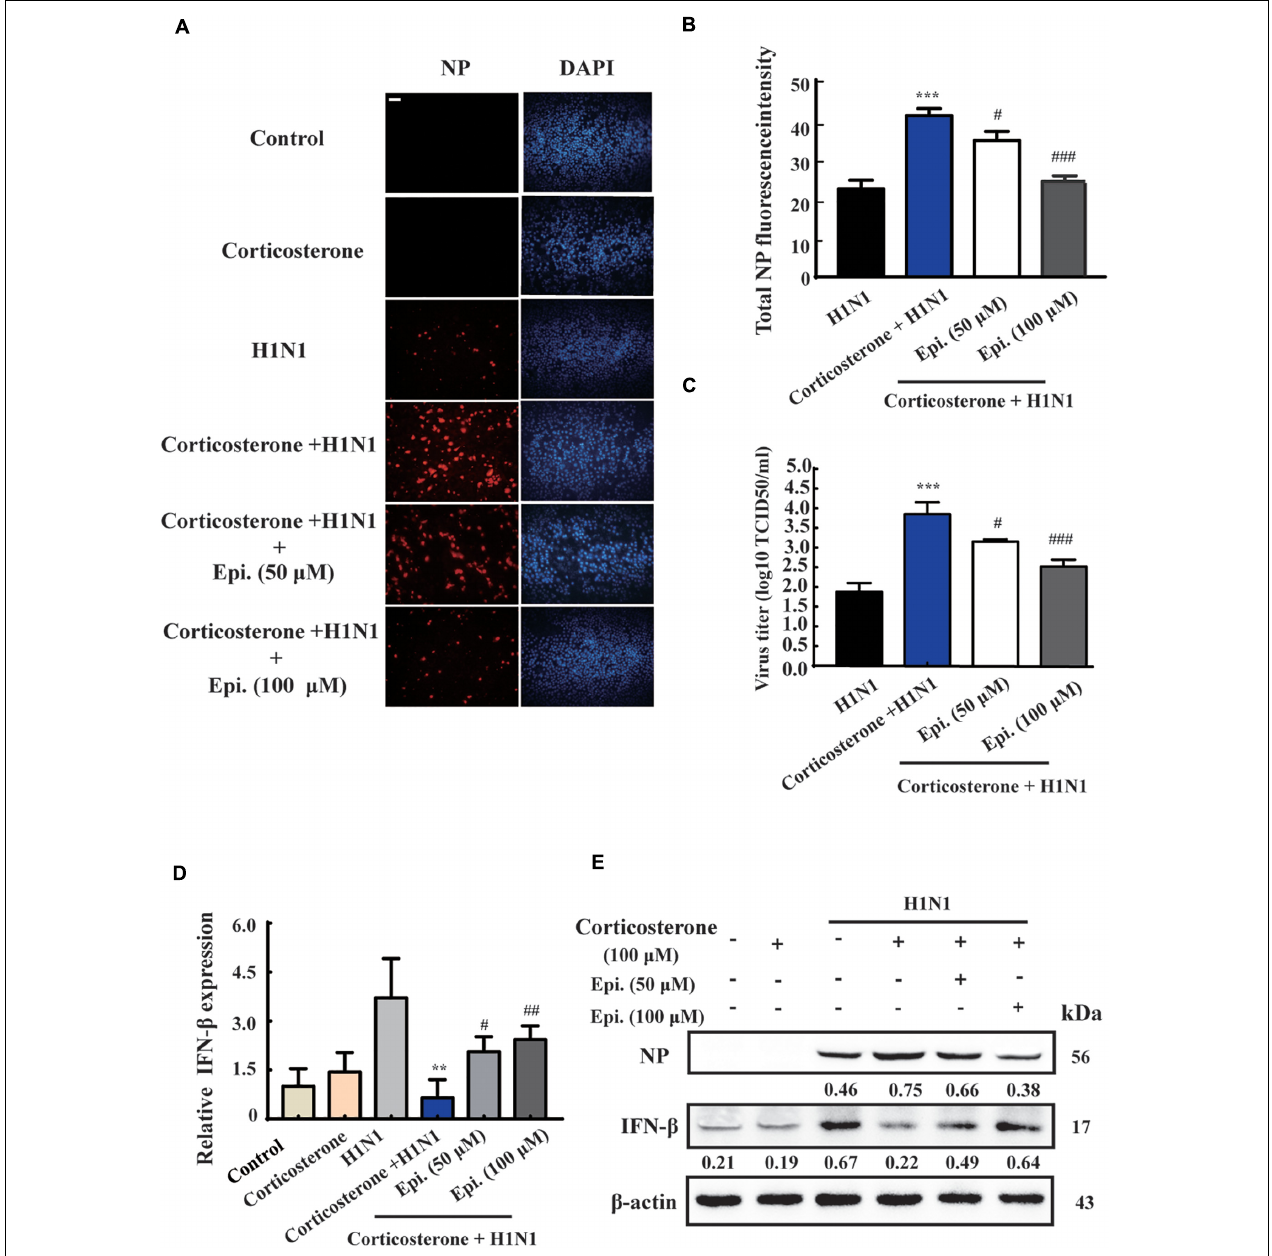
FIGURE 5 | Epigoitrin inhibited H1N1 replication and promoted IFN- β generation after influenza infection in stress cell model. (A) Cells stained for influenza A virus NP at 12 hpi (red) and the cell nuclei were stained by DAPI (blue). Bar = 50 µ m. (B) The total fluorescent intensity was determined to reflect the levels of NP. (C) Related infectious viral titer was detected by TCID 50 assay. (D,E) Effects of epigoitrin on IFN- β gene and protein expression were analyzed by qRT-PCR and Western blotting. The difference was considered statistically significant at ∗∗ P < 0.01, ∗∗∗ P < 0.001 vs. H1N1 group; # P < 0.05, ## P < 0.01, ### P < 0.001 vs. corticosterone +H1N1